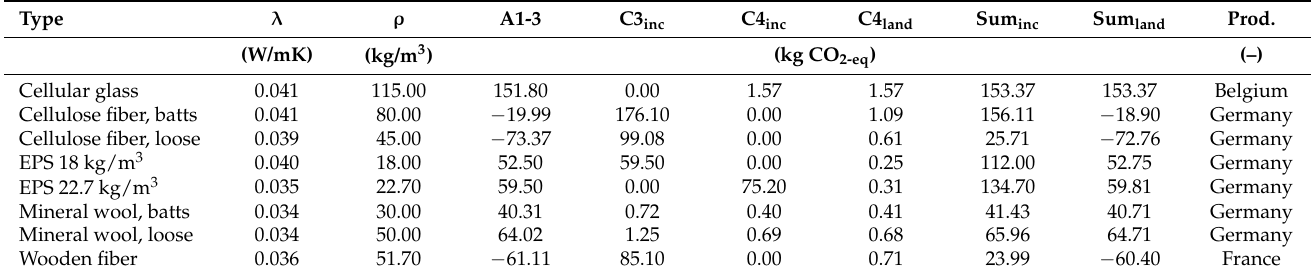
Table 3. Presentation of materials included in the tool. Descriptions of Life Cycle Stages are presented in Figure 2.